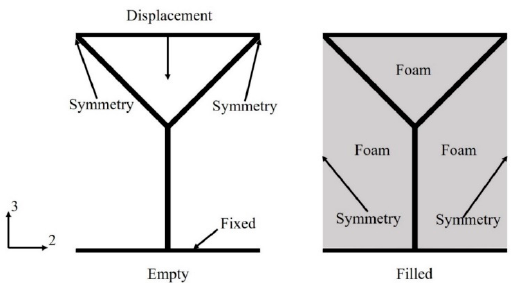
Figure 3. Geometry and boundary conditions of FE models for compression tests of both empty and aluminum foam-filled Y-shape cored sandwich panels.